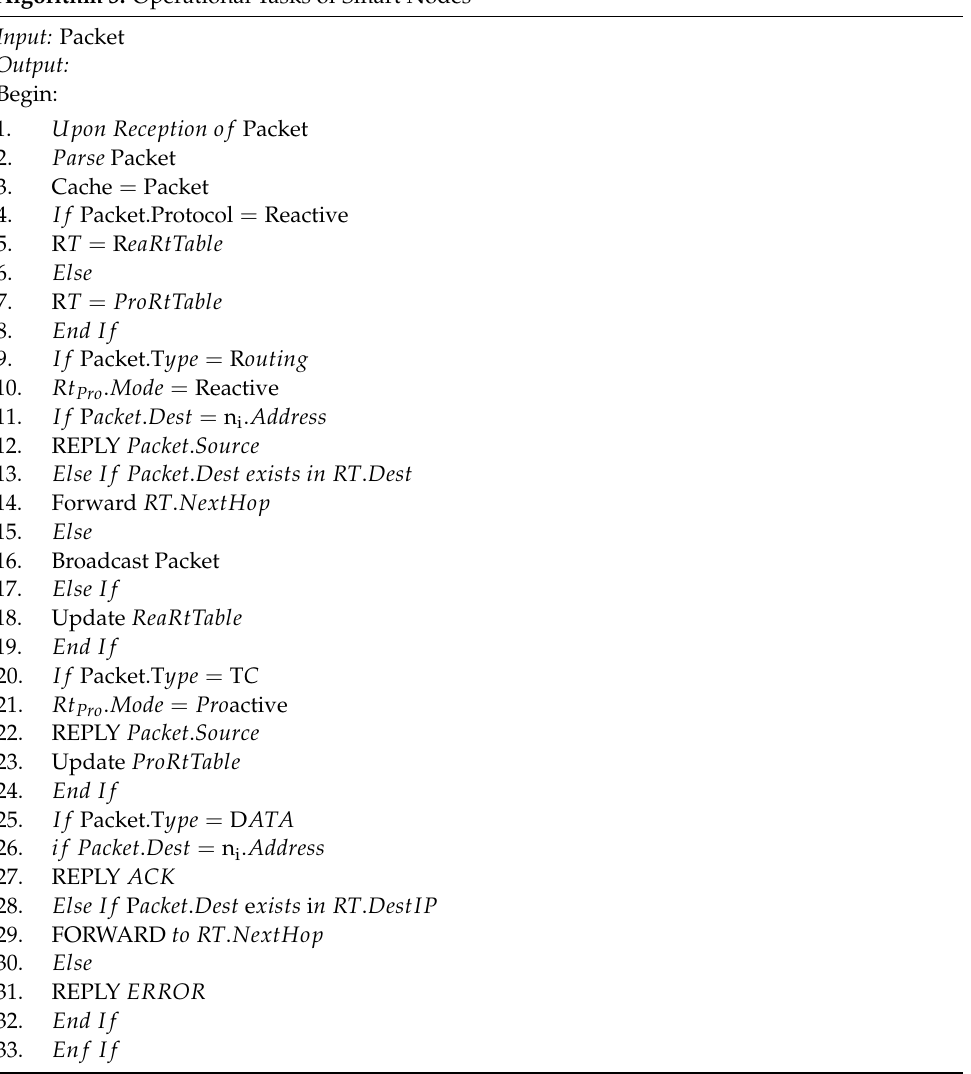
Algorithm 3: Operational Tasks of Smart